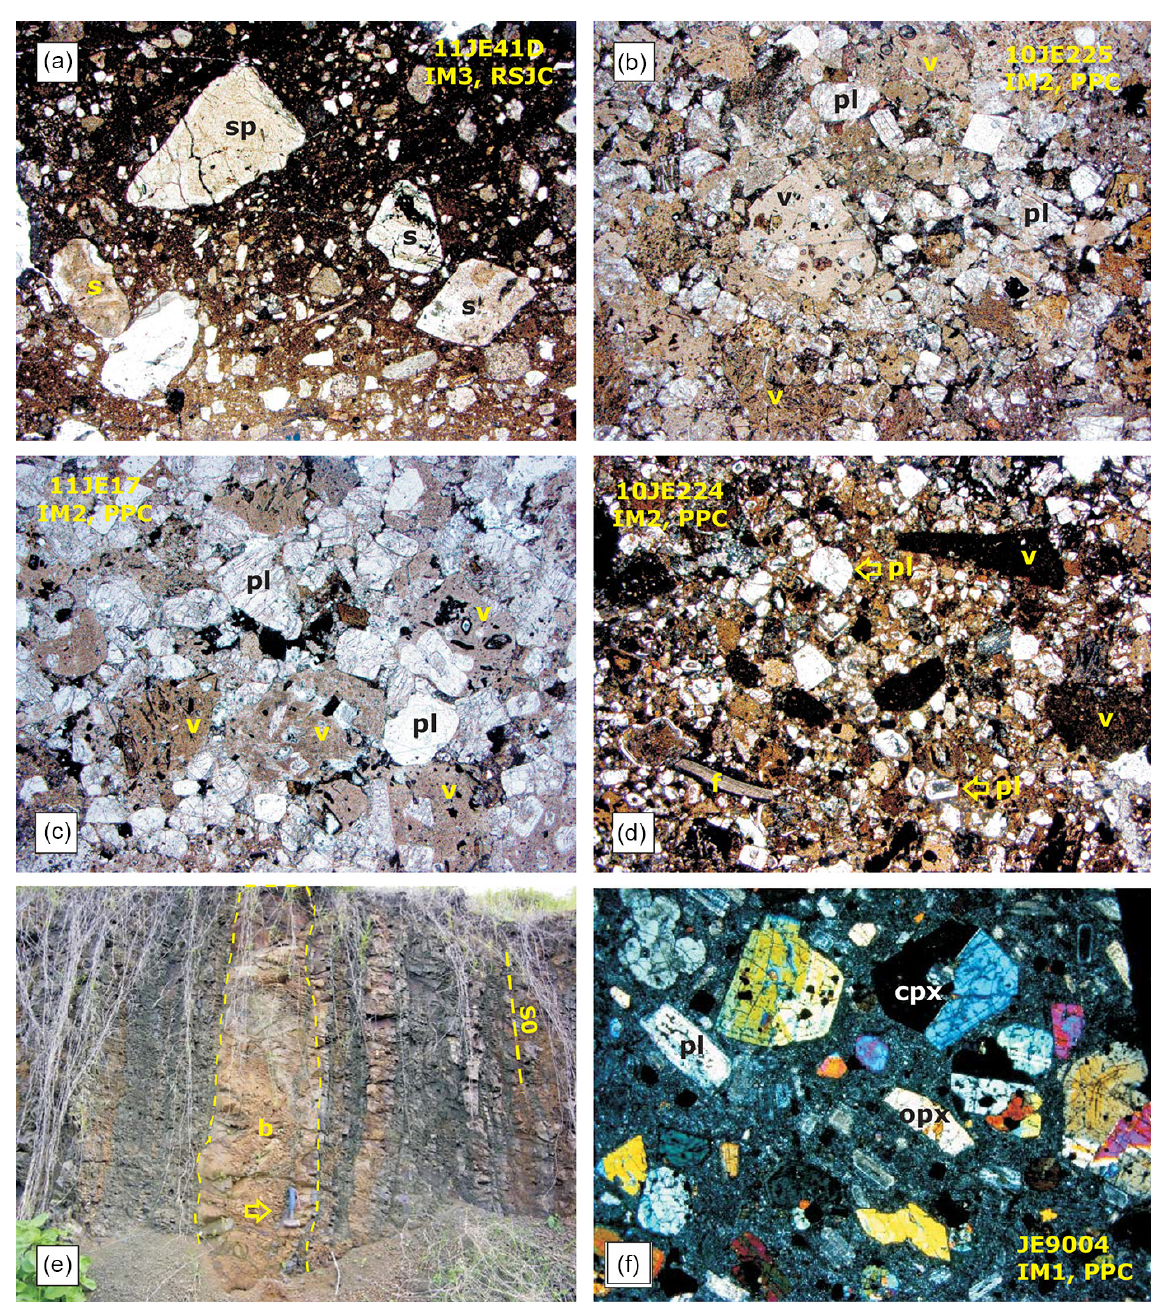
Figure 6. (a–d) Microphotographs (PPL) of the Imbert Fm sandstones and matrix of the breccias consisting of microlitic volcanic rock ( v ), plagioclase (pl), serpentinized peridotite (sp), serpentinite rock fragments ( s ), and rare microfossils (f) . Volcanic sources of the grains range in composition from basaltic to andesitic. Note the absence of quartz grains. Sandstone grains composition suggest provenance from erosion of volcanic arc and ophiolitic complexes. (e) Basaltic sill intruding an alternance of fine-grained sandstone, siltstone and laminated mudstone of the IM1 unit, Rancho Brugal section. (f) Basalt with microporphyritic textures defined by clinopyroxene (cpx), plagioclase (pl) and orthopyroxene (opx) micro-phenocrysts